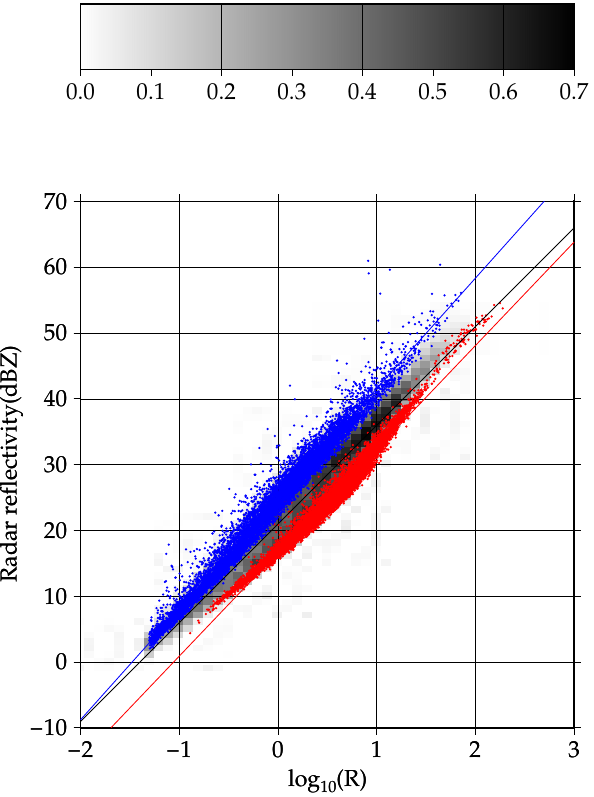
Figure 8. Relationship between radar reflectivity Z (dBZ) and rain rate R (mm h − 1 ). Solid black line is the regression line represented by Z ( mm 6 m − 3 ) = 124 R 1.50 ( mm h − 1 ) .The red and blue points are the data of PC 2 > + 1.5 and PC 2 < − 1.5, respectively. The solid red and blue lines are the regression lines of the red and blue points,